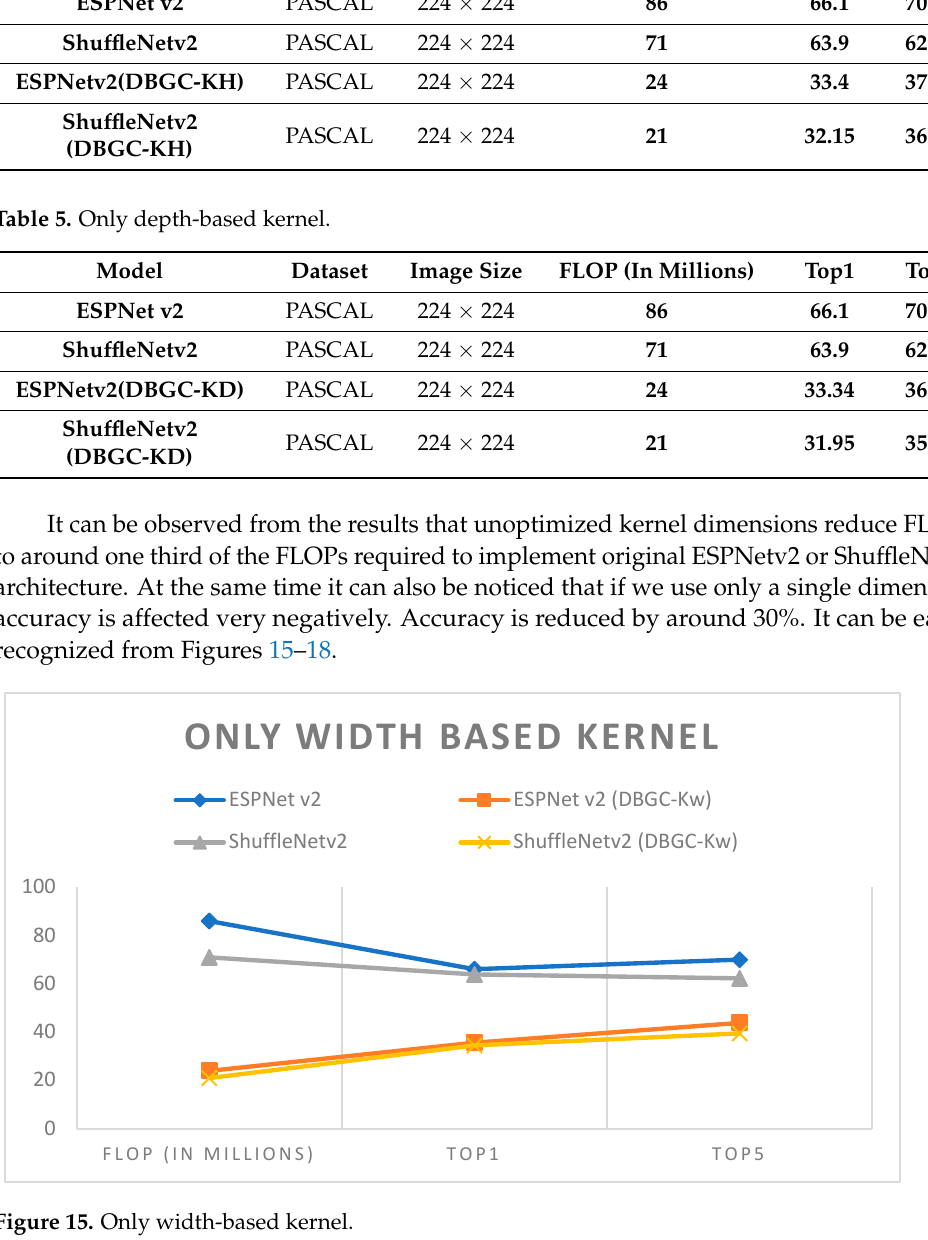
Table 3. Only width-based kernel.